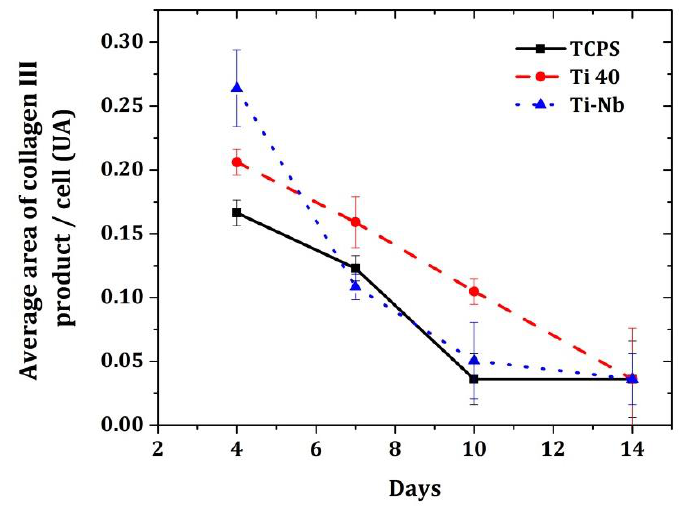
Figure 3. Production of type III collagen by fibroblasts under three culture conditions: culture on TCPS, Ti40, and TiNb.